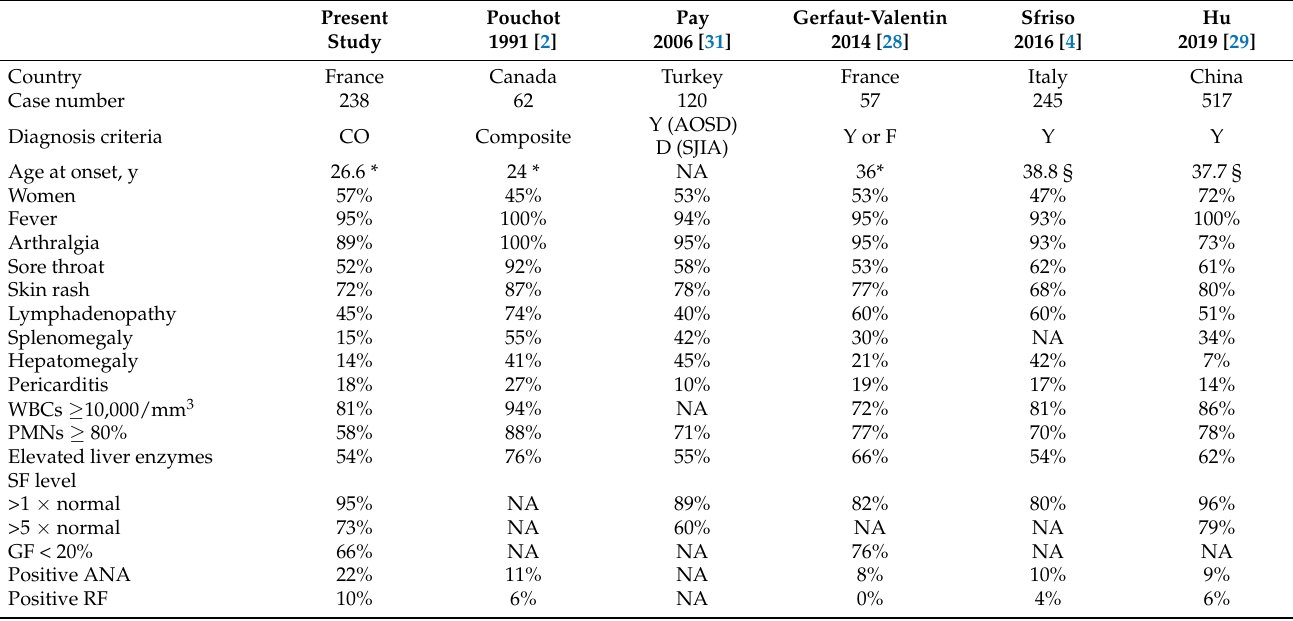
Table 4. Comparison of our cohort with five previously published